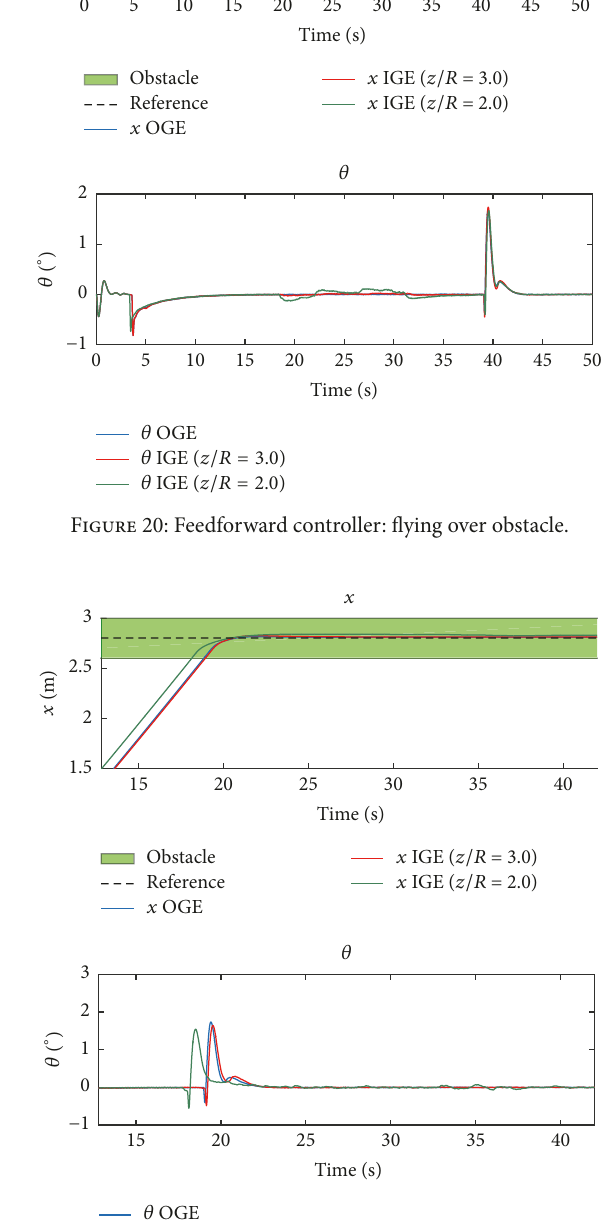
from the real one. Offset errors in the horizontal plane